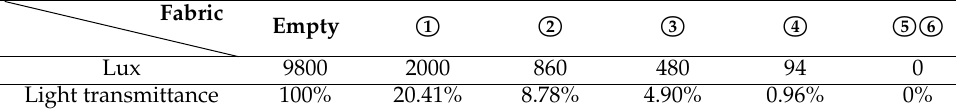
Table 3. Light transmittance measurement of curtain fabrics in Figure 11b.